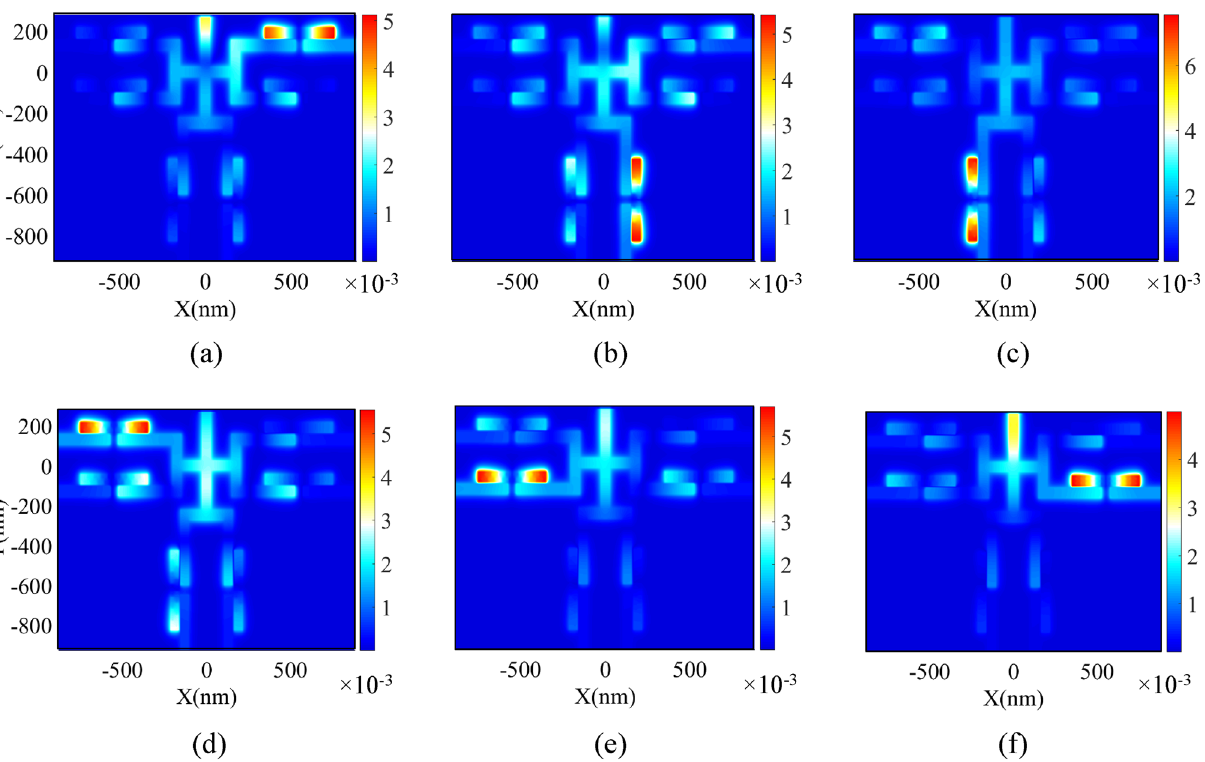
Figure 14. Field profile of | H z | for 1 × 6 DEMUX at the wavelength of (a) 1385, (b) 1479, (c) 1553, (d) 1628, (e) 1736, (f) 1883